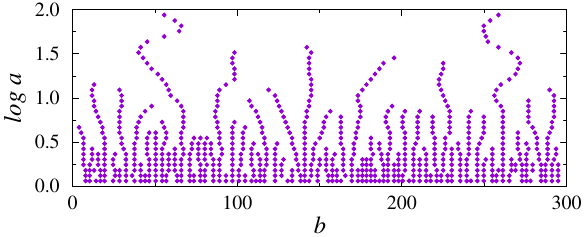
Fig. 2. Skeleton estimated with the continuous wavelet- transform using the MHAT-function.